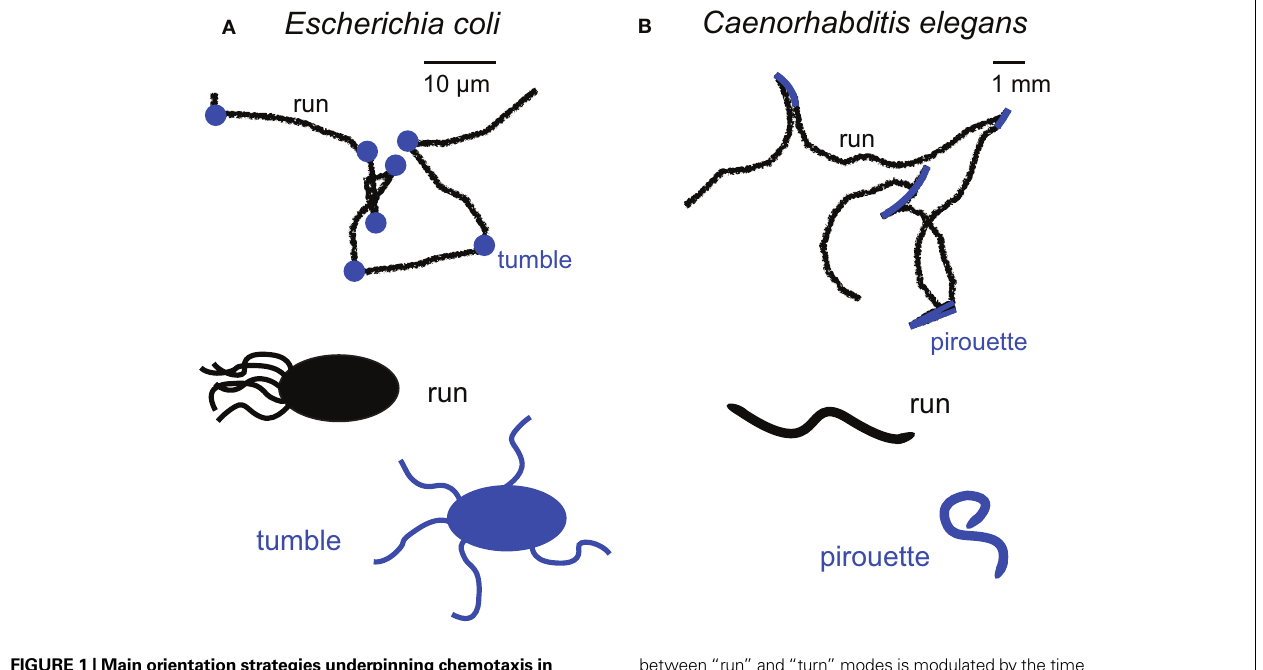
between “run” and “turn” modes is modulated by the time derivative of the concentration experienced by the organism. This simple mechanism leads to indirect navigation ( kinesis ) towards attractants and away from